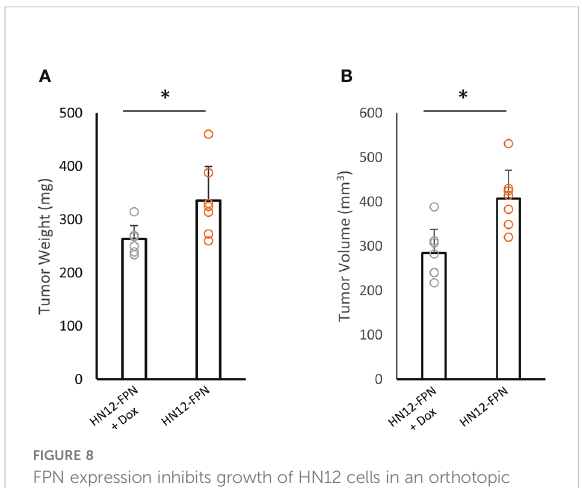
FIGURE 8 FPN expression inhibits growth of HN12 cells in an orthotopic xenograft model. HN12-FPN cells were implanted into the left cheek of mice and allowed to form tumors for 5 days. FPN expression was induced by adding 2mg/mL Doxycycline to the drinking water of mice. Control mice received normal drinking water. After 21 days, tumors were harvested and tumor weight (A) and tumor volume (B) were measured. For each group n=7 mice.